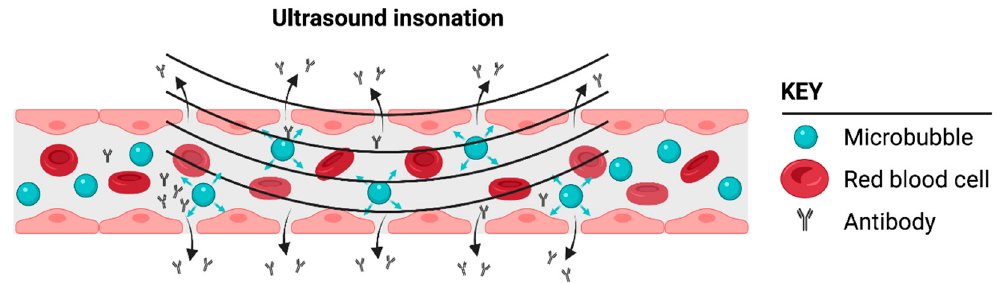
Figure 3. Cartoon illustrating how microbubbles can induce a focal disruption or opening of the blood–brain barrier (BBB), thus enabling the delivery of a biologic such as a monoclonal antibody. Microbubbles flow through the normal vasculature or vasculature supplying the glioblastoma tumor microenvironment (TME). Only the microbubbles in the vasculature exposed to ultrasound insonation enable BBB/BTB disruption following ultrasound insonation. Created with